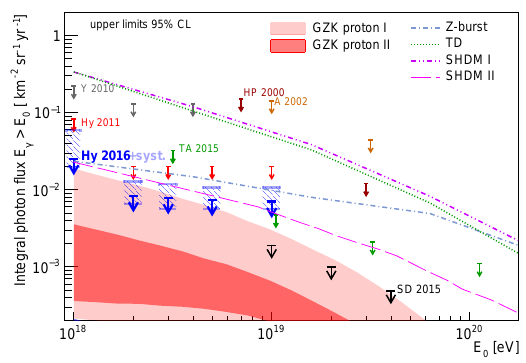
Figure 8. Upper limits on the integral photon flux (blue arrows, Hy 2016) with hybrid data collected between January 2005 and December 2013[9]. When the systematic uncertainties of the de- tector are taken into account the obtained limits are indicated by the light-blue dashed boxes around the blue arrows. Also shown are the limits previously published by the Pierre Auger Observa- tory (Hy 2011 and SD 2015) and other experiments (Telescope Array, Yakutsk, AGASA, Haverah Park). The shaded regions and the lines give the predictions for photon fluxes from cosmo- genic models and several top-down models (Z-burst, topological defects, super-heavy dark matter, see [9] for a full list of refer-